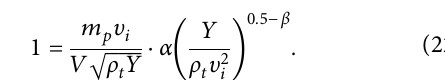
Figure 15: The relation between dimensionless Π on the energy